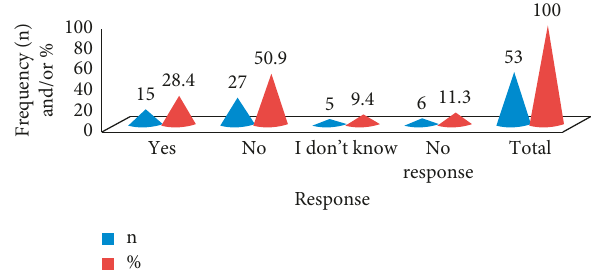
Figure 7: Response to the importance of wild animals’ survival in the study area.